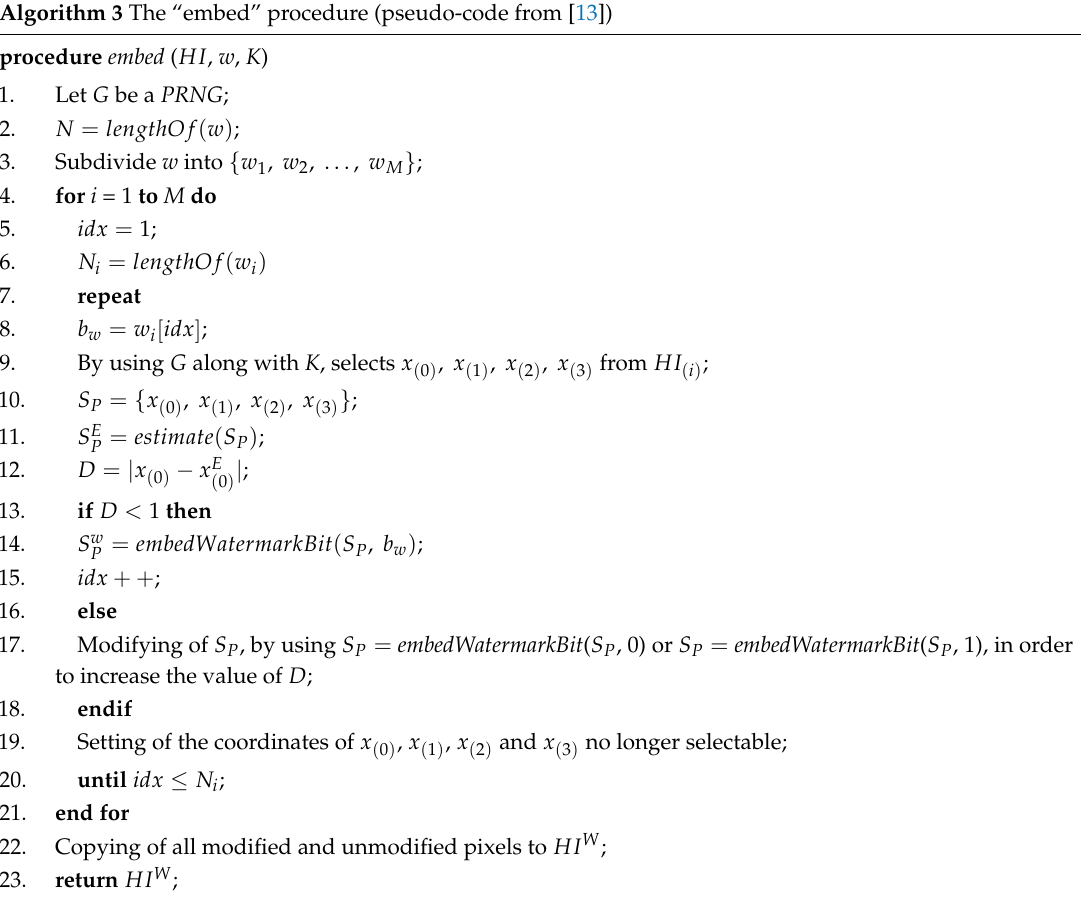
Algorithm 3 The “embed” procedure (pseudo-code from [13]) procedure embed ( HI , w , K